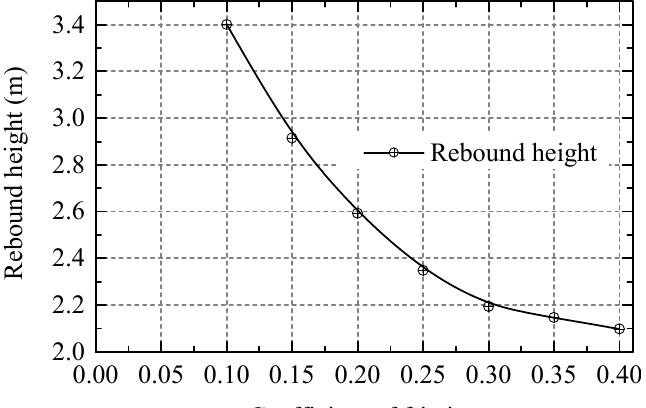
Figure 11. Variations of rebound height vs. different lithology viscosity between the barrel and the